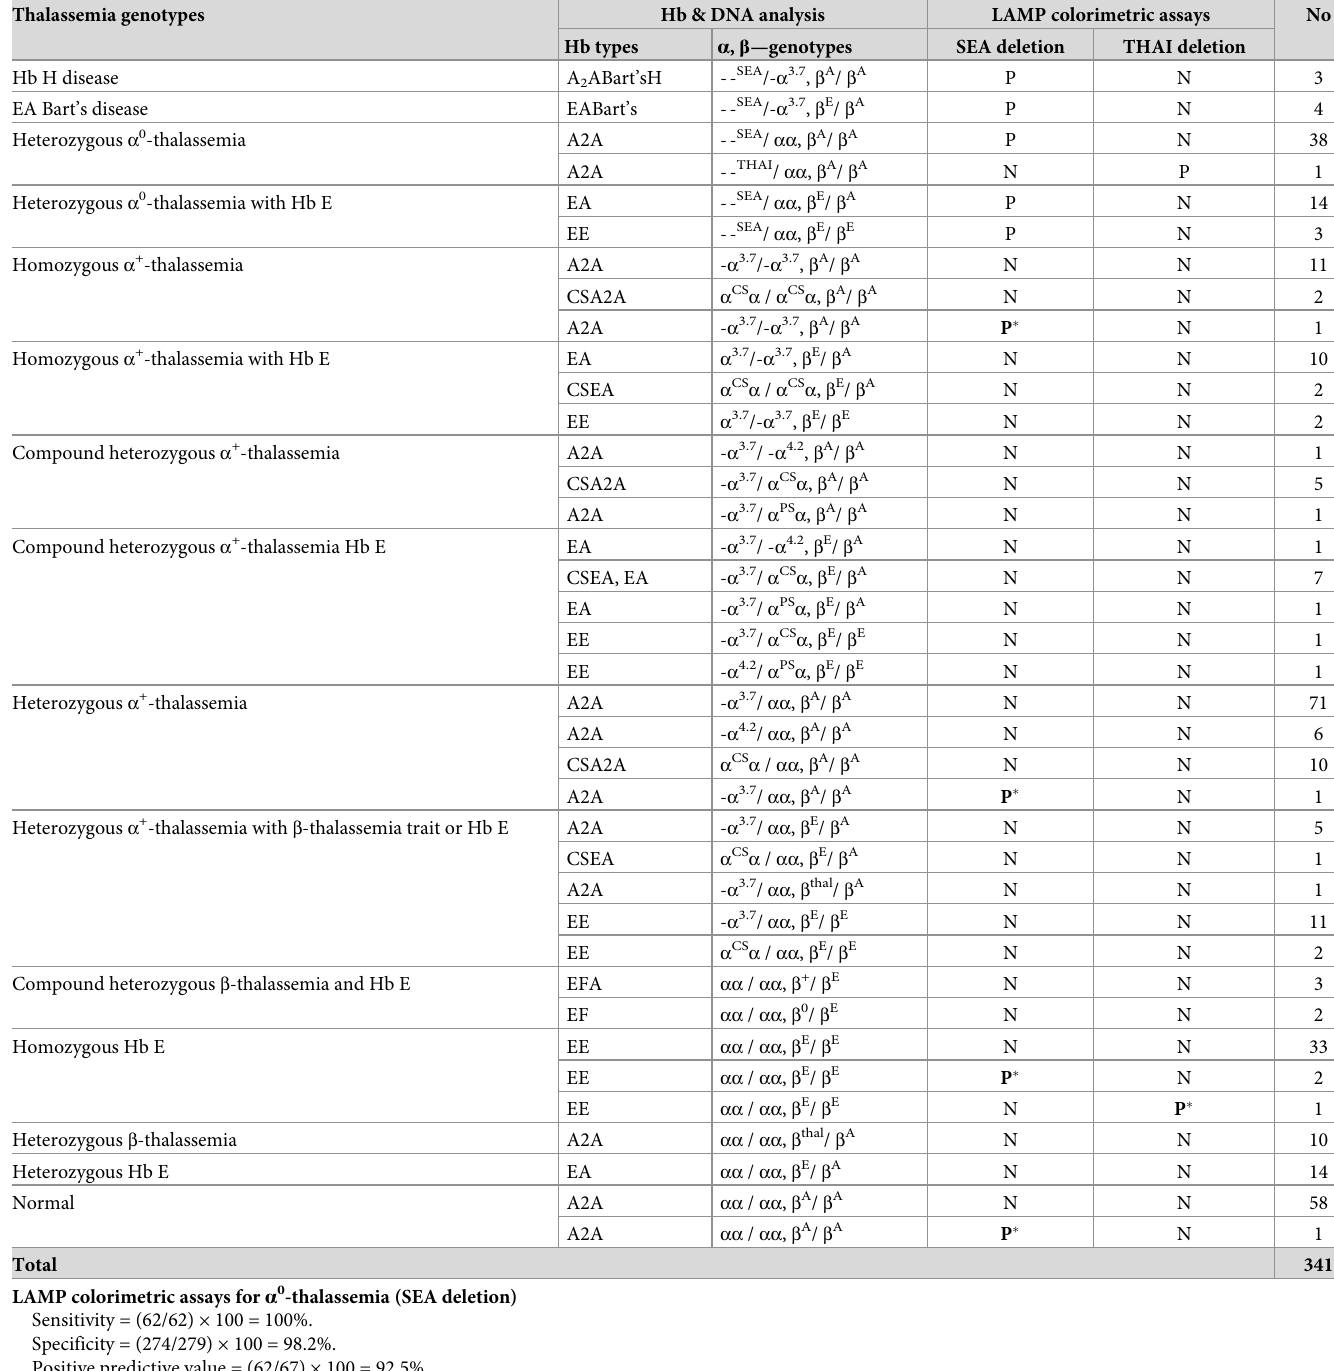
Table 2. Thalassemia genotypes of 341 subjects with positive (P) and negative (N) in the LAMP colorimetric assays for α 0 -thalassemia (SEA deletion and THAI deletion). P & N are positive and negative, respectively. P � indicates false positive result of the LAMP assays.